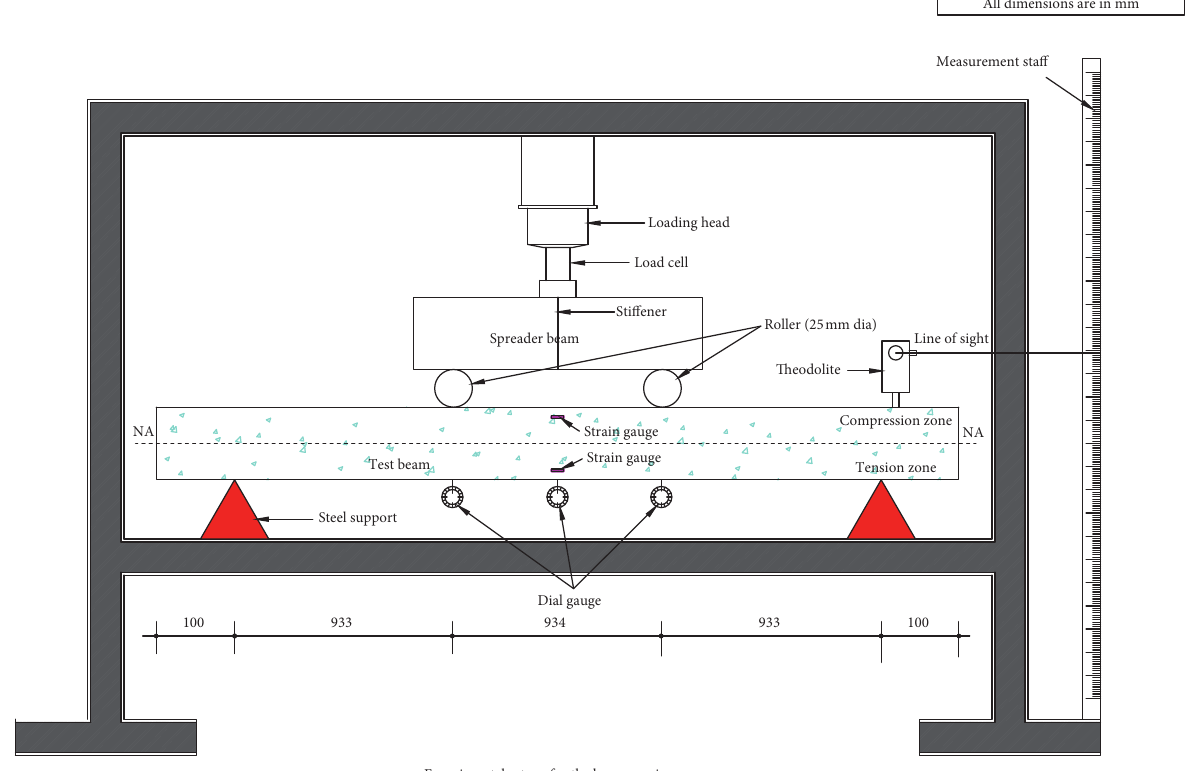
Figure 4: Schematic diagram of beam